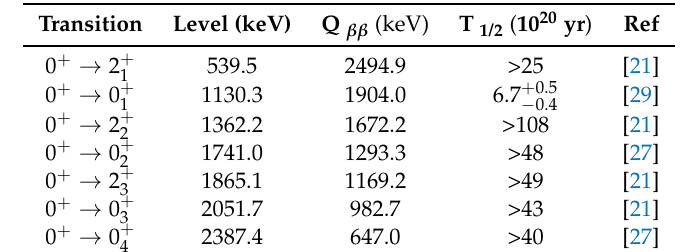
Table 1. Experimental results on T 1/2 of the 2 β − decay of 100 Mo to the excited states of 100 Ru. All limits are given at 90%